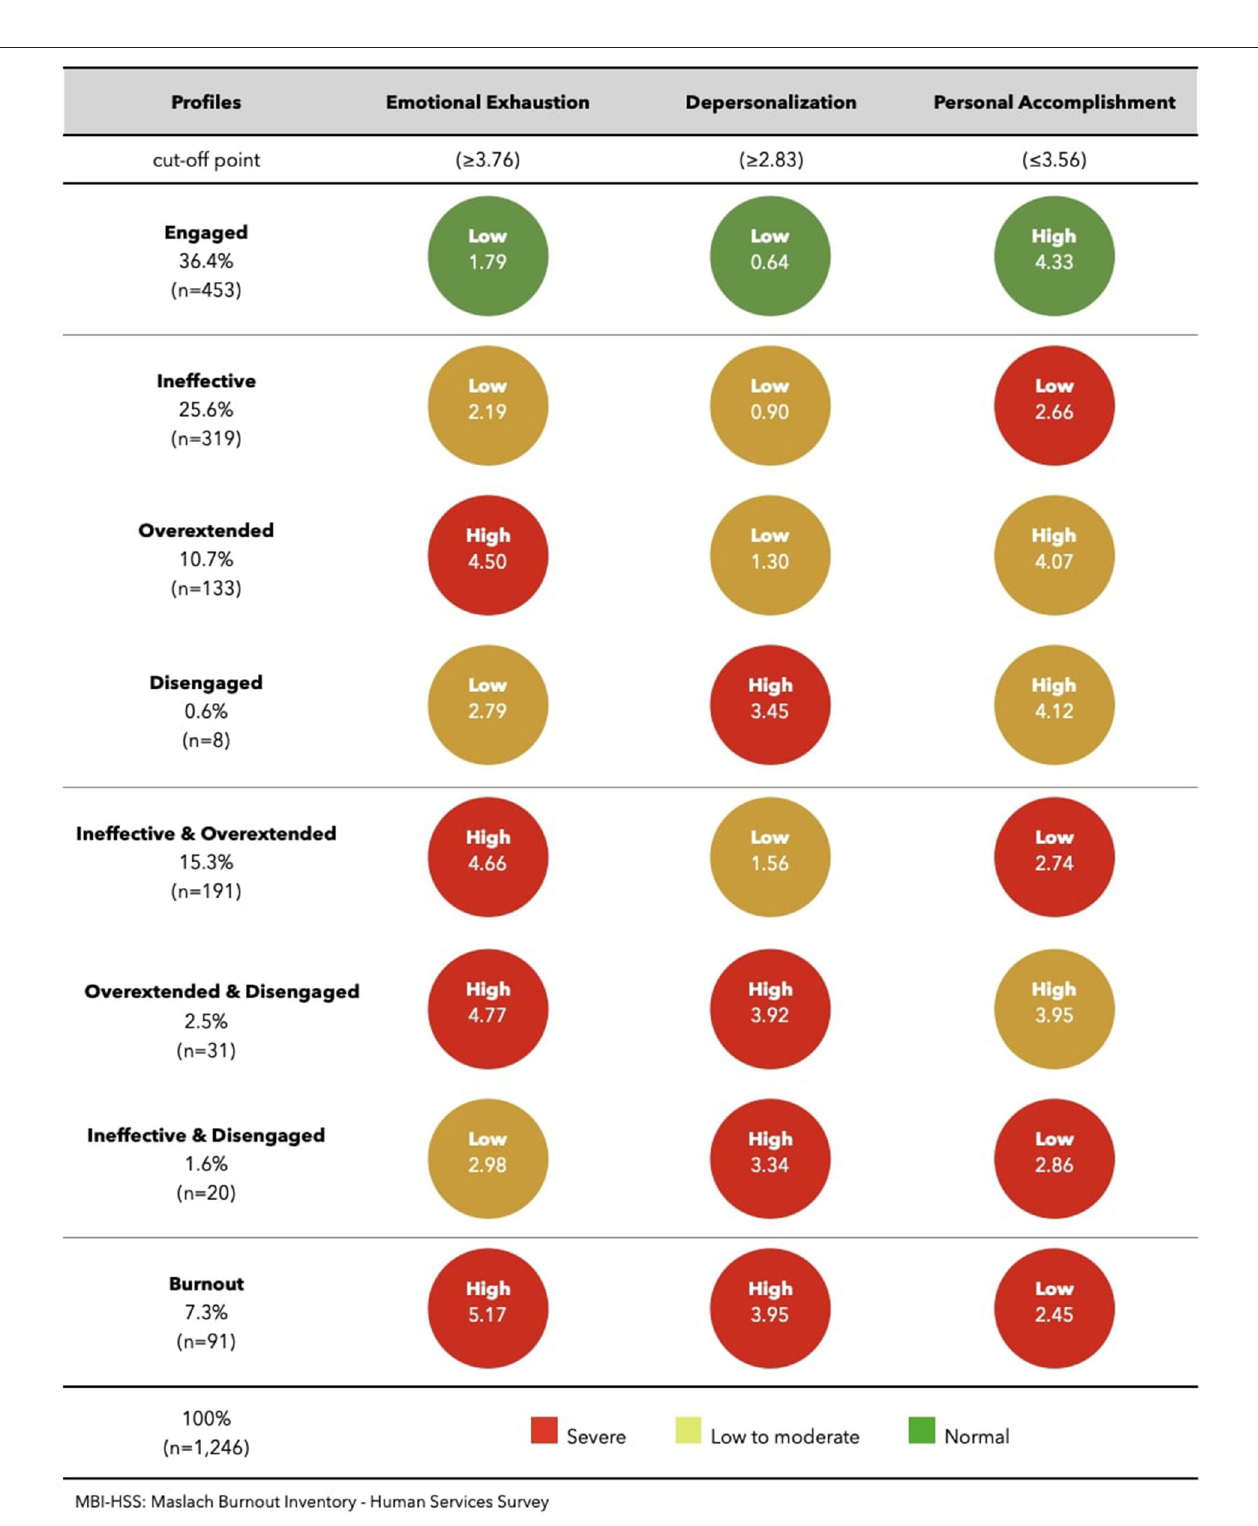
FIGURE 1 | Pattern of MBI-HSS subscales across profiles: pharmacists involved in direct patient care activity.